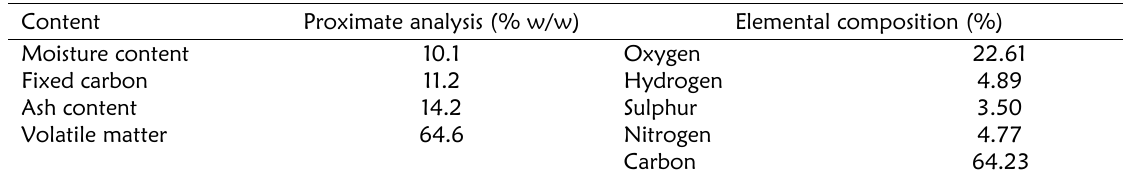
Table 1: Proximate and ultimate analysis of coconut shell powder Source: Tanmaya (2011) Content